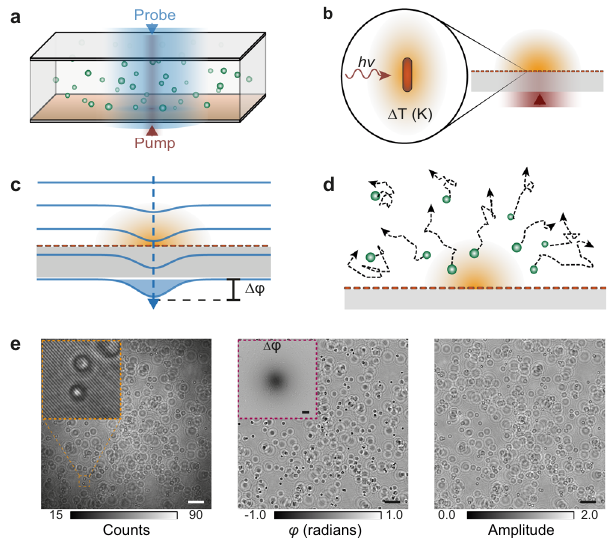
Fig. 1 Plasmon heating-based opto fl uidic platform. a Schematic diagram of the model fl ow cell system composed of two coverslips separated by a silicon spacer of known size, which is illuminated by counter-propagating pump and probe beams. The fl ow cell is fi lled with a solution containing 1.0 µ m microspheres as tracer particles and the bottom glass is functionalized with a uniform distribution of gold nanorods to ef fi ciently transduce light into localized heat. b Plasmon heating is achieved by resonant illumination of the immobilized AuNRs on the glass surface, resulting in a temperature gradient that extends over the area delimited by the pump beam. c The established temperature gradient in the sample leads to an overall change in the optical path length of the incident probe wavefront which is detectable in the form of a phase difference via a wavefront sensor. d The dynamics of the fl uid in the presence of a localized temperature gradient are studied by following the motion of tracer particles via the principle of single-particle-tracking velocimetry. e As an optical readout platform of ( c ) and ( d ) we use a digital holographic microscope, whereby the measured hologram (inset: zoom of the highlighted area) is separated into a phase (inset: measured phase difference caused by heating) and amplitude channel, which report on the temperature and fl uid dynamics, respectively. Scale bars: 10 µ